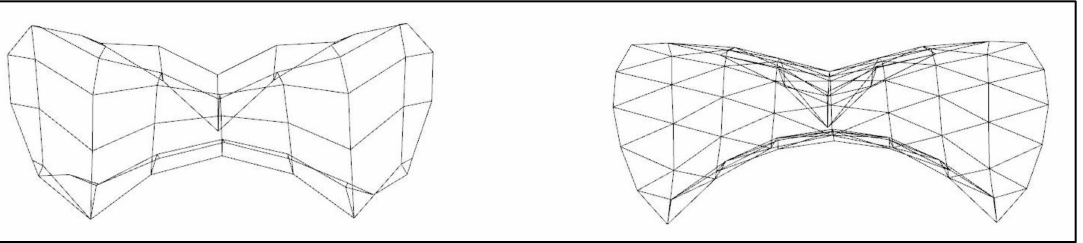
Figure 6. Geometries generated according to Finding 1–fixed total length in the grid-shell~1390 m (left–rectangular, right–triangular). Both meshes present a smooth surface but with dense mesh (authors compilation).